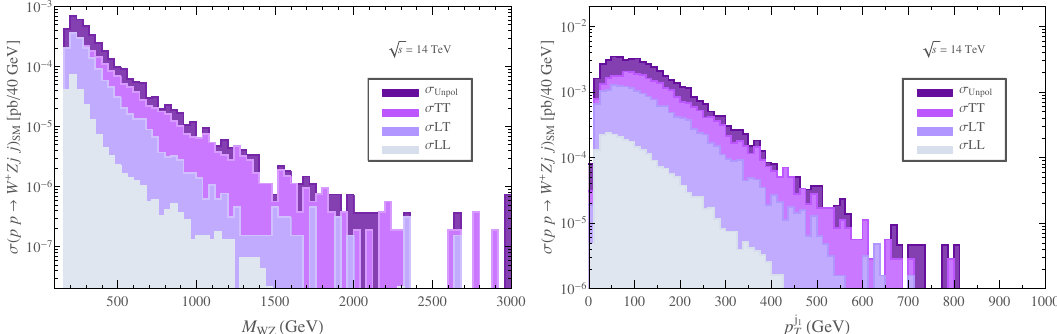
Figure 12 . (cid:27) ( pp W + Zjj ) distributions of the SM-EW background with the invariant mass of ! the WZ pair, M WZ (left panel) and with the transverse momentum of the most energetic jet, p j 1 T (right panel). The imposed cuts are (cid:17) j < 5 ; (cid:17) j (cid:17) j < 0 and (cid:17) W;Z < 2. The predictions 1 ;j 2 j 1 (cid:1) 2 j j j for the various polarizations (cid:27) AB of the (cid:12)nal W A Z B pair as well as the total unpolarized, (cid:27) Unpol , result are displayed separately, for comparison. Starting from the upper to the lower lines they correspond respectively to: (cid:27) Unpol , (cid:27) TT , (cid:27) LT and (cid:27) LL